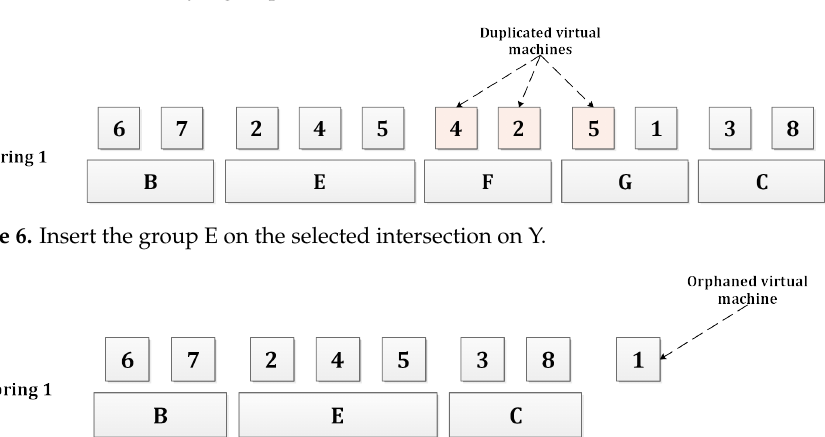
Figure 5. Select randomly a group from X and an intersection on Y.